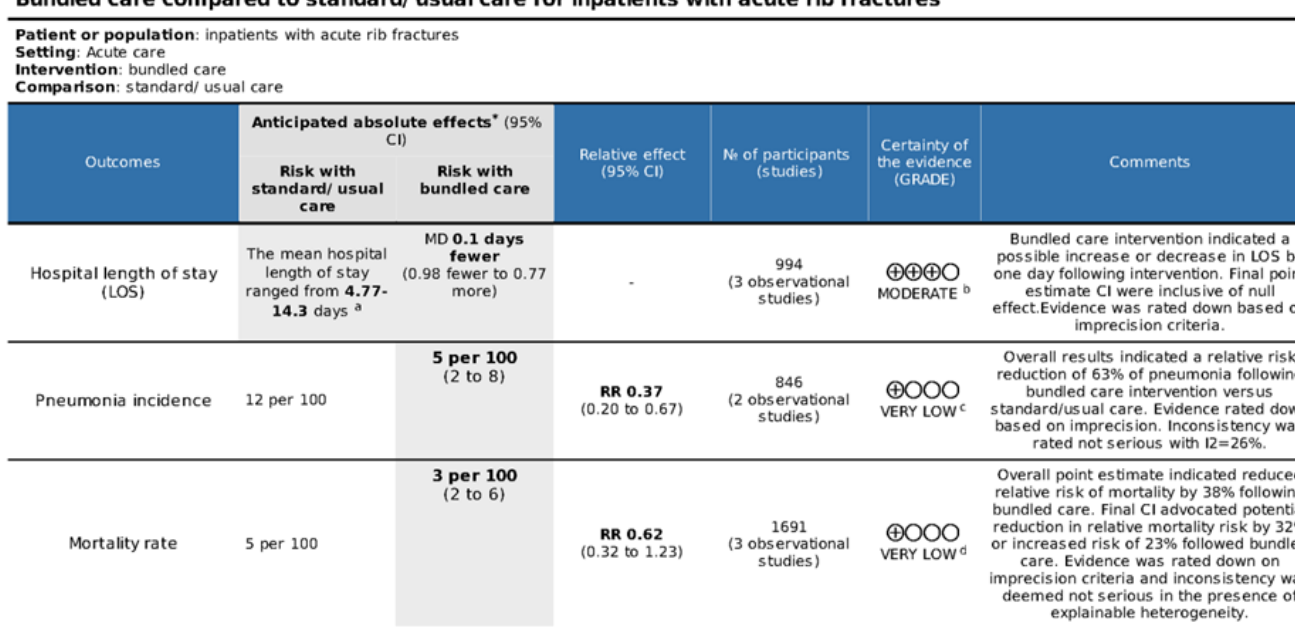
TABLE 9-A1: Summary of